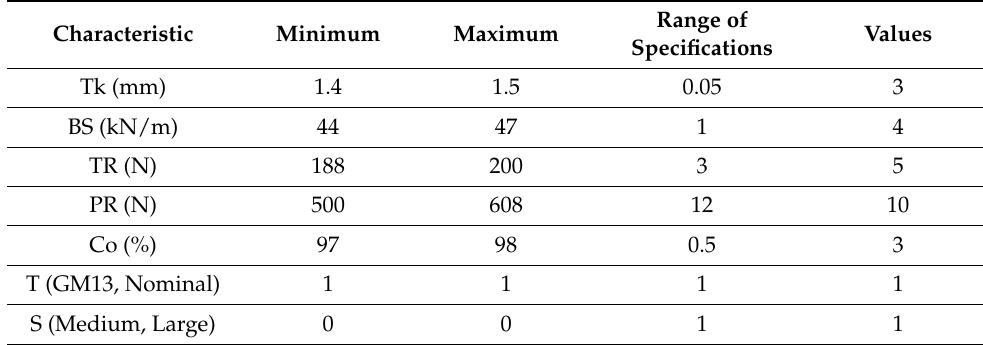
Table 3. Suitable ranges of geomembrane characteristics.